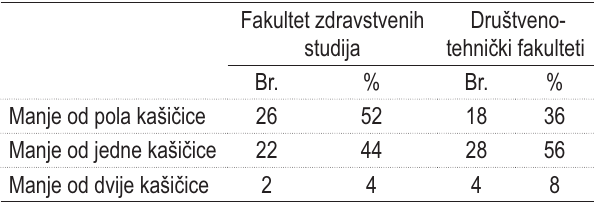
U Tabeli 2 prikazano je znanje studenata o preporuče- nom dnevnom unosu soli u organizam. Sa FZS 26 stu- denata (52 %) smatra da je dnevni preporučeni unos soli manje od pola kašičice, 22 studenta, odnosno 44